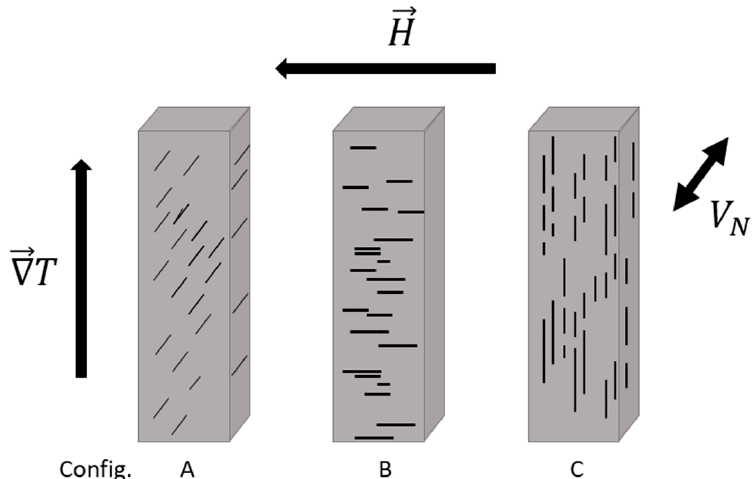
Figure 6. Illustration of the three different cuts made from each sample vis-à-vis the direction of the magnetic field applied during the magnetic anneal, labeled as the MnBi “needle” direction: ( A ) needles are parallel to the Nernst voltage; ( B ) needles are parallel to the applied magnetic field; ( C ) needles are parallel to the temperature gradient. In the longitudinal measurements (resistivity and thermopower), the current, temperature gradient, and induced voltages are all parallel to the long axis of the parallelepipeds. Nernst measurements are made with ∇ T and H applied and the Nernst voltage ( V N ) measured as indicated. Given MnBi’s spin-orientation behavior, a Nernst measurement in configuration A corresponds to the traditional spin-Seebeck effect (SSE) geometry below 90 K and configuration B above 140 K. Configuration C was used as a control.